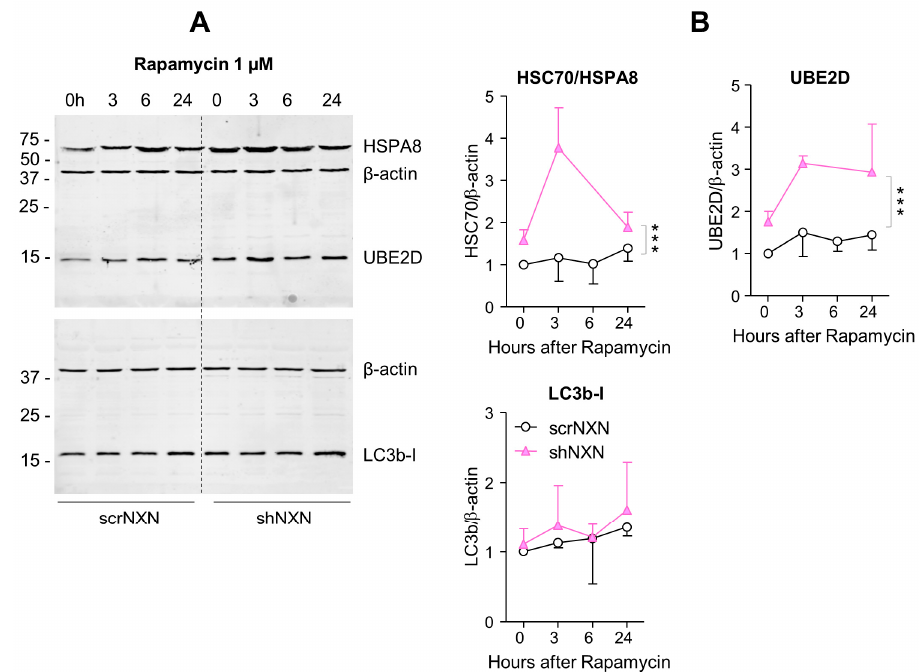
Figure 5. Western blot analysis of autophagy markers upon rapamycin stimulation. ( A , B ) In analogy to Figure 3, Western blots show results after stimulation with 1 µM rapamycin. The time courses of HSC70/HSPA8, UBE2D and LC3b were analyzed. Owing to highly stimulated autophagy at this dose, LC3b-II was not detectable. Statistical comparison by Wilcoxon matched pairs rank test, sample size n = 3 per group and time point. Asterisks indicate differences between groups *** p < 0.001. Raw Western blot data in Supplementary Figure S4.